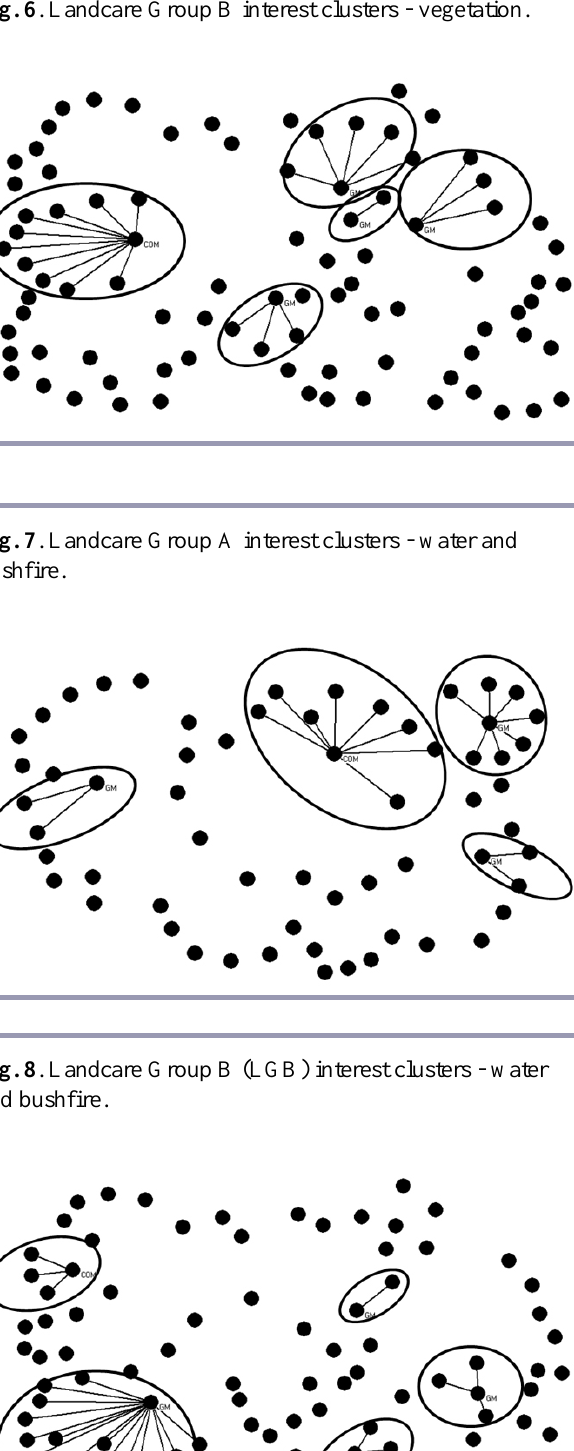
Fig. 6 . Landcare Group B interest clusters - vegetation.